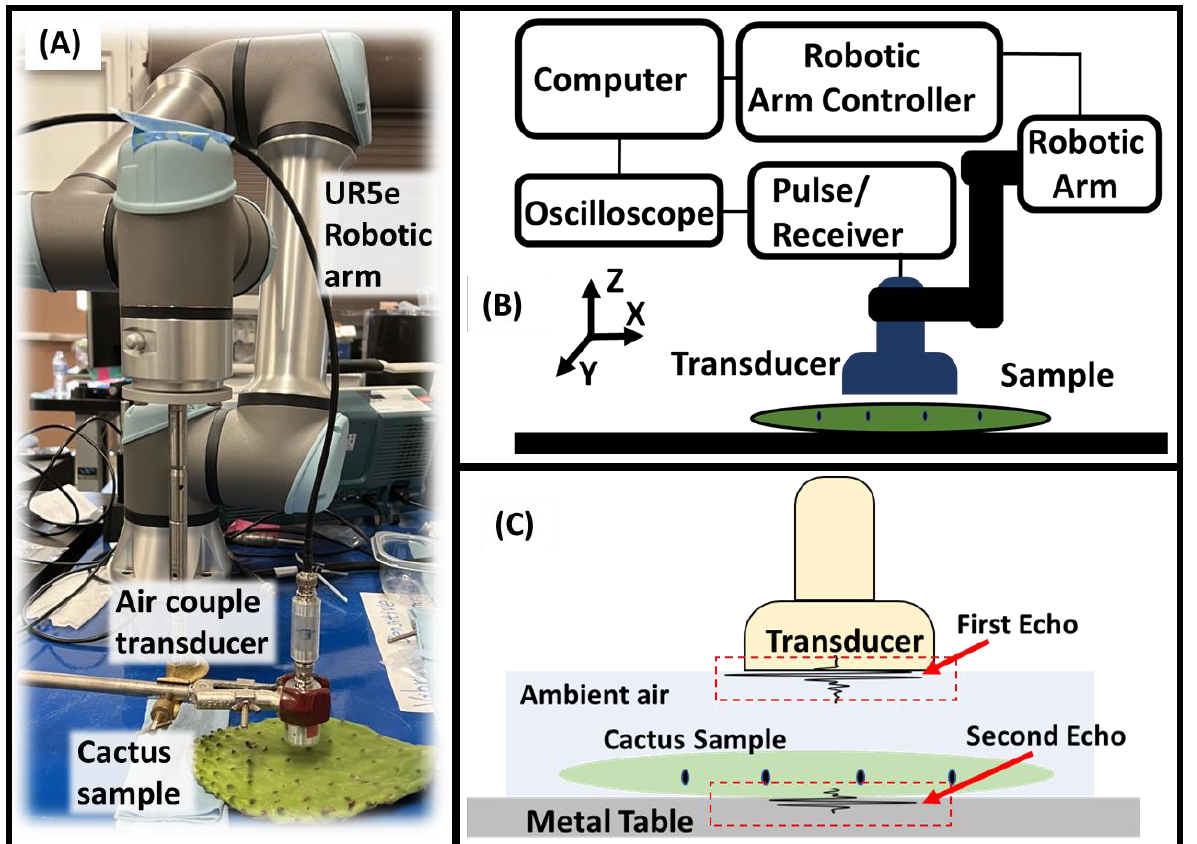
Figure 1. ( A ) The overall experiment setup: a UR-5 robotic arm was used to hold the air-coupled transducer and perform the scan. The scan area and scan path were controlled via MATLAB script. A prickly pear (nopal) pad bought from a MEXICO supermarket was used as specimen and placed in a lab environment at temperature 𝑇 0 = 20 °C and relative humidity around 4 – 50%; ( B ) schematic picture of all the components, including computer, robotic arm controller, robotic arm, oscilloscope, pulse/receiver, and an air-coupled transducer; ( C ) the elaboration of the measurement configuration. The volume of matter between the air-coupled transducer and the metal table was measured as a homogenized material. The variation in the cactus’s physical properties contributed to the effective value, as indicated by the effective medium approximation.